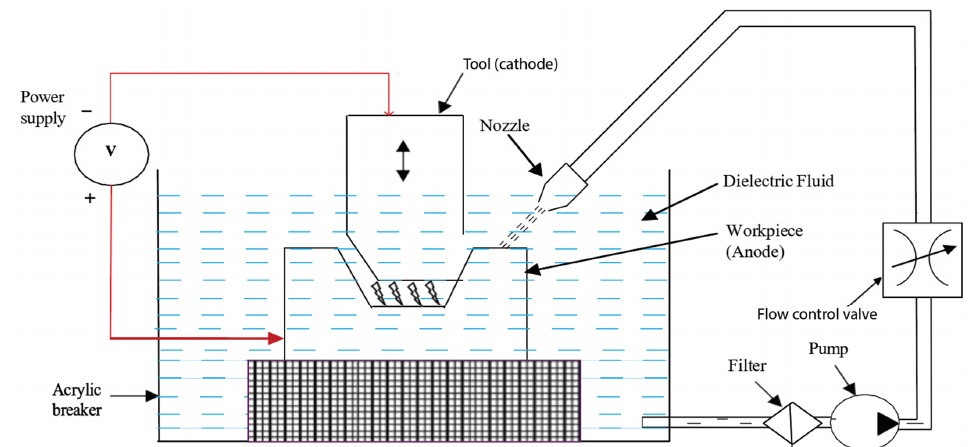
Figure 11. Micro-EDM schematics [221]